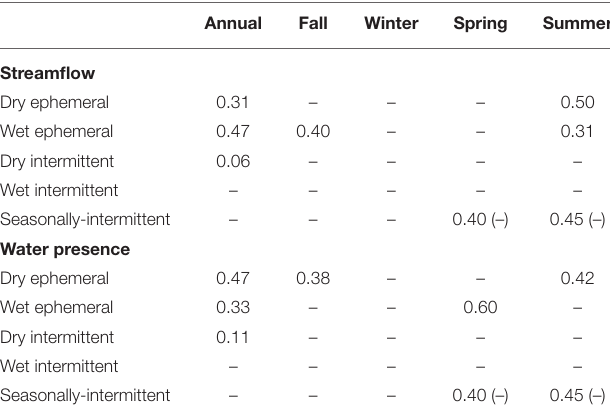
TABLE 4 | Coefficient of determination ( r 2 ) values for significant ( p < 0.05) regressions of percent streamflow and water presence vs.